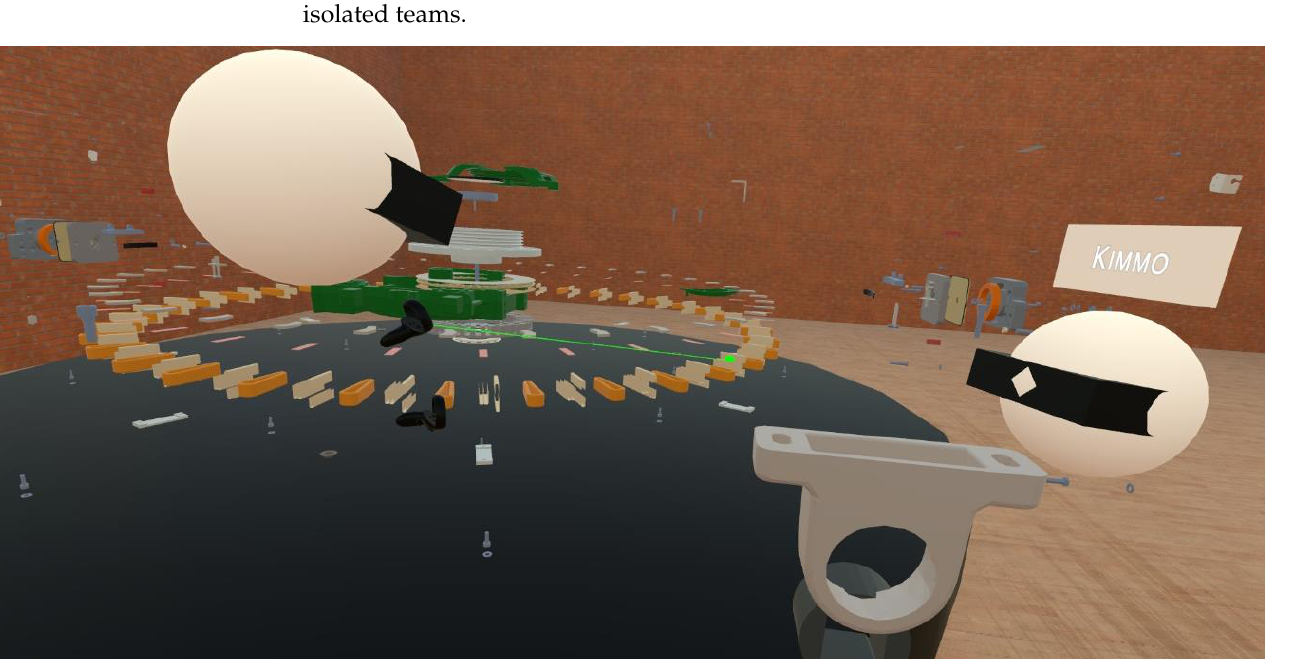
Figure 1. Multi-user interaction in COVE-VR platform.